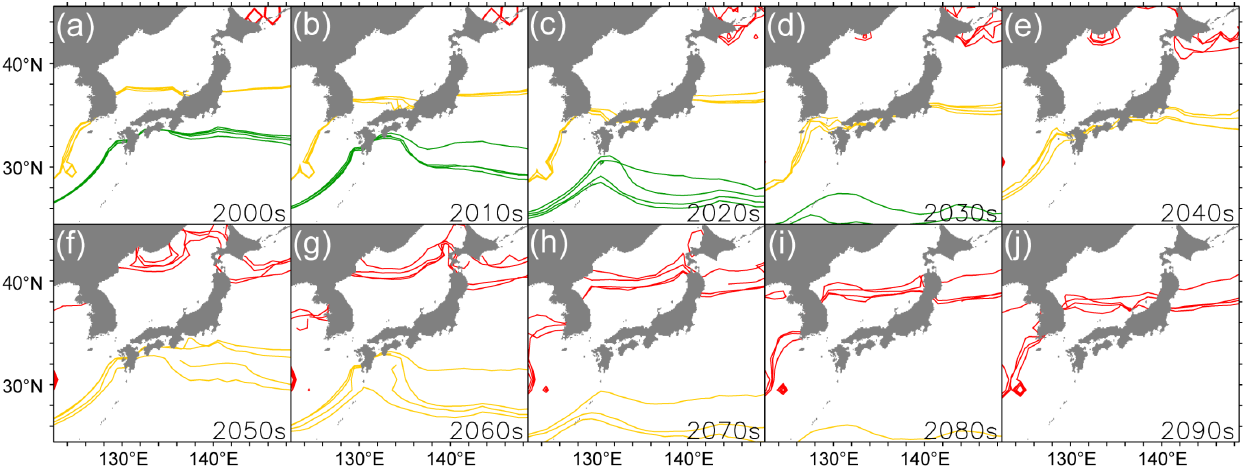
Fig. 7b. Same as in Fig. 7a, but for projected 10-yr mean northern limit of tropical/subtropical coral communities (defined by the isolines of (cid:127) arag = 3; green lines) and temperate coral occurrence (defined by the isolines of (cid:127) arag = 2 . 3; yellow lines), defined by (cid:127) arag as the lowest value in each decade. Red lines denote the isolines of (cid:127) arag = 1 as a criterion for the aragonite undersaturation